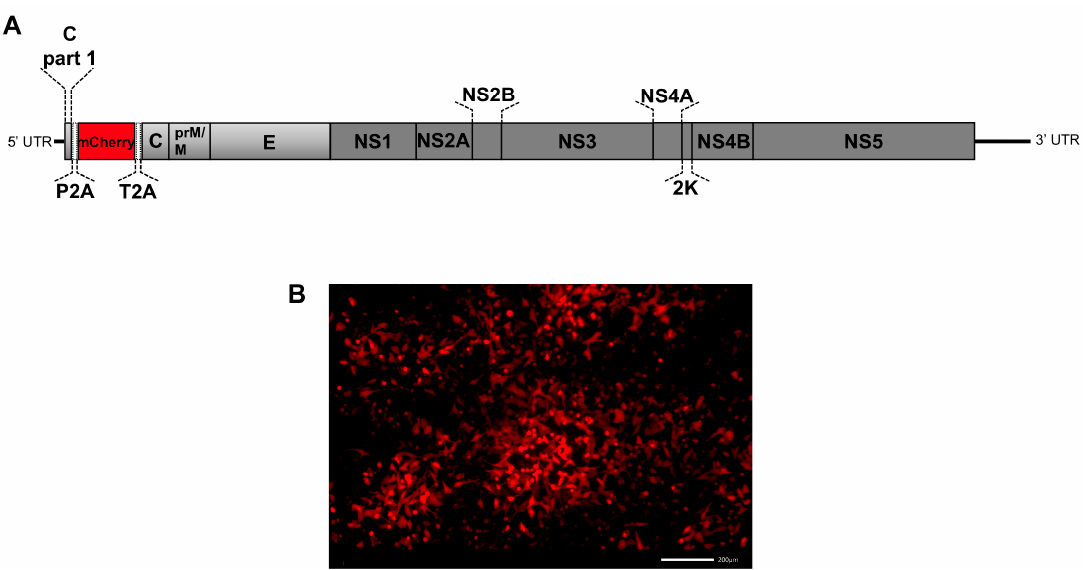
Figure 1. Genome structure of the reporter mCherry Hypr TBEV developed by Haviernik et al. in 2021 [22]. The mCherry coding sequence, flanked by the ribosome skipping sequences P2A and T2A, was inserted downstream of the first 72 nucleotides of the capsid gene, followed by the full-length open reading frame of the capsid gene ( A ). The image below shows a red native mCherry fluorescence in BKH-21 cells infected with passage 0 (P0) mCherry Hypr TBEV ( B